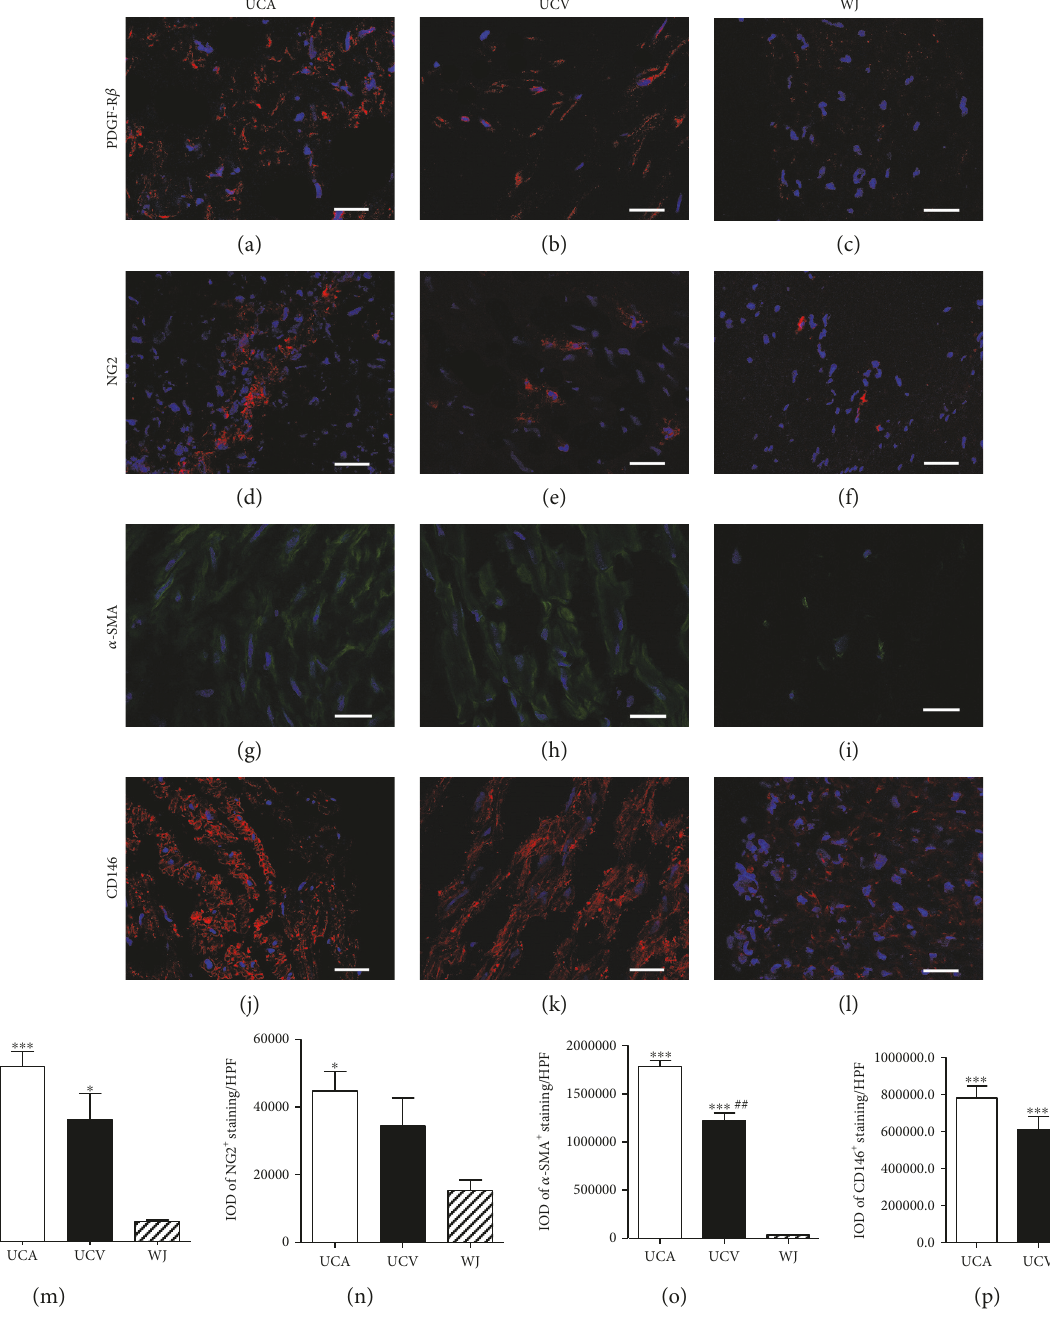
Figure 1: Immunolocalization of PDGF-R β , NG2, α -SMA, and CD146 in the human umbilical cord. Fluorescence imaging revealed a high incidence of PDGF-R β -positive (a – c), NG2-positive (d – f), α -SMA-positive (g – i), and CD146-positive (j – l) cells in the perivascular region. Bar: 25 μ m. The integrated optical density (IOD) values of positive staining in fi ve randomly selected high power fi elds of view were counted. ∗∗∗ P < 0 001 , versus WJ-MSCs. ∗ P < 0 05 , versus WJ-MSCs. ## P < 0 01 , UCV-PSCs versus